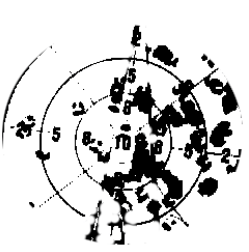
Figure 27. Target image.